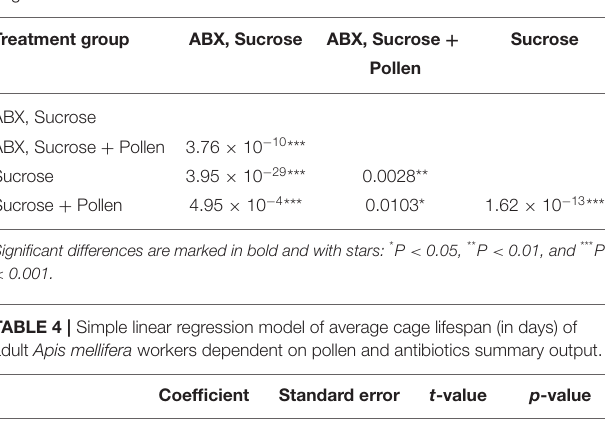
TABLE 3 | Bonferroni corrected pairwise comparisons of worker longevity using Log-Rank